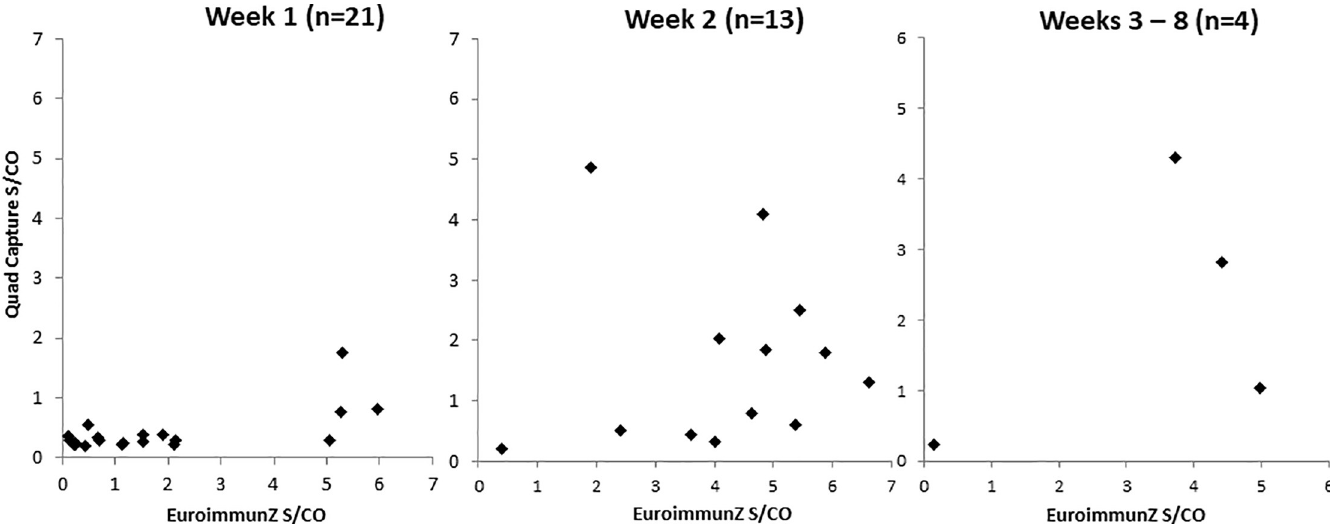
Fig 6. Zika seroconversion panels: EuroimmunZ vs Quadrivalent antigen quenched G capture by time from infection. X by Y plots of sample reactivity, expressed as sample to cut off ratios in G capture assay using quad quenched conjugate and in EuroimmunZ, of 38 samples grouped by time since onset of symptoms.